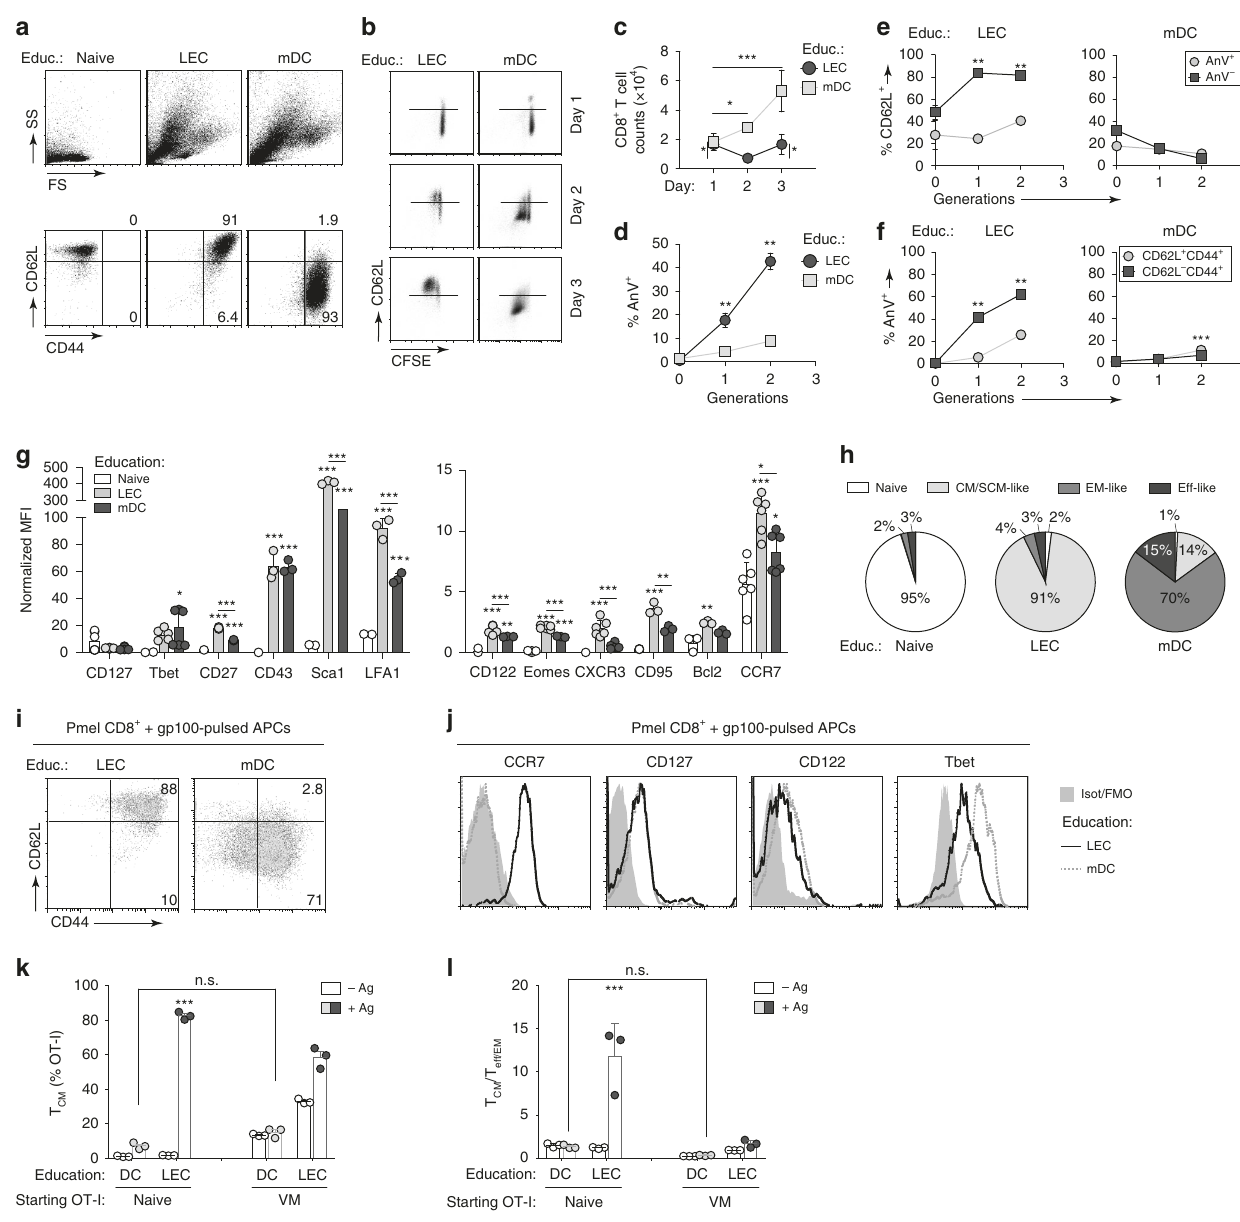
Fig. 4 Surviving LEC-primed CD8 + T cells express T CM /T SCM -like phenotype. Flow cytometry analysis of phenotype of naïve CFSE-labeled OT-I cells following 3 days co-culture (unless otherwise noted) with Ag-pulsed LECs or mDCs. As a control, resting naïve OT-I cells have been shown (Educ: Naïve). a Representative dot plots showing the size and granularity (top) and CD62L and CD44 expression (bottom) of OT-I cells following various co-culture conditions. b Representative dot plots of CD62L expression versus CFSE dilution. c Absolute recovery of live LEC or mDC-educated cells versus time in co- culture. d Percentage of OT-I cells within each generation that stain positive for the apoptotic marker Annexin V (AnV) following 2 days co-culture. e Frequency of CD62L + cells per generation gated on AnV + or AnV − OT-I cells, or conversely, f AnV + cells gated on the T eff/EM -like (CD44 + CD62L − ) or T CM -like (CD44 + CD62L + ) cells following 2 days co-culture. g Normalized mean fl uorescence intensity (MFI; fold-change relative to isotype control) for indicated phenotypic markers in CD44 − CD62L + naïve, versus CD44 + CD62L + LEC-educated, versus CD44 + CD62L − mDC-educated cells. h Composition